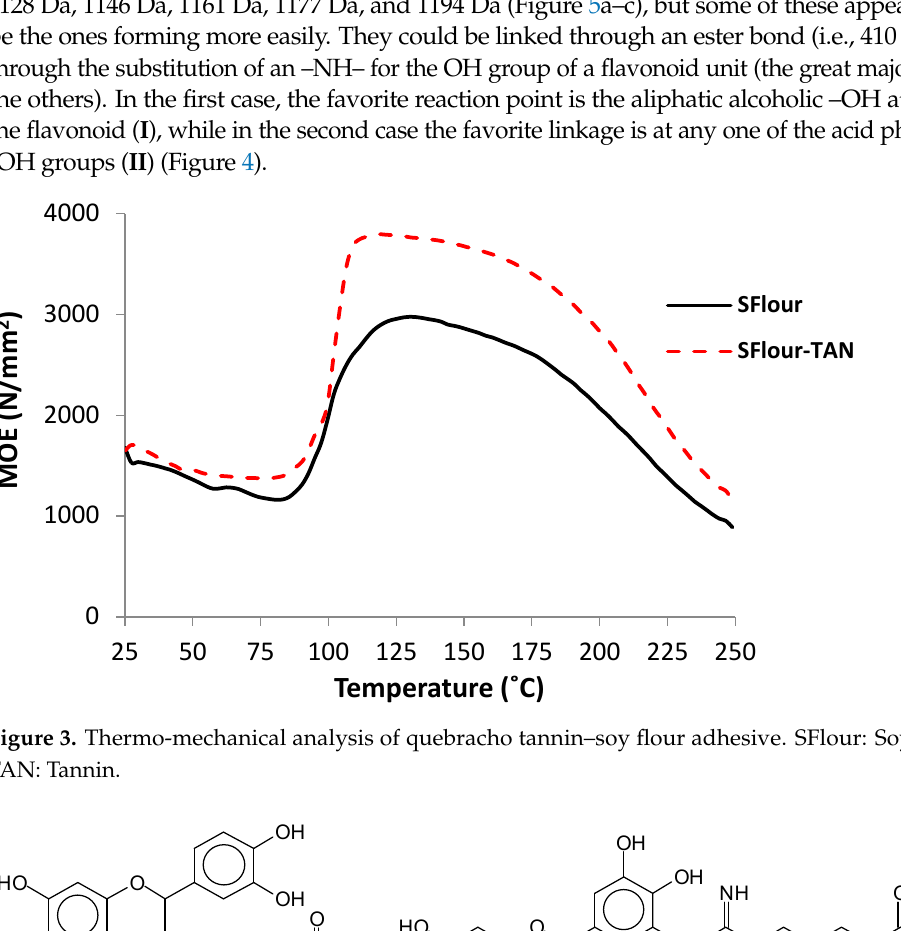
Figure 3. Thermo-mechanical analysis of quebracho tannin–soy flour adhesive. SFlour : Soy flour; TAN: Tannin